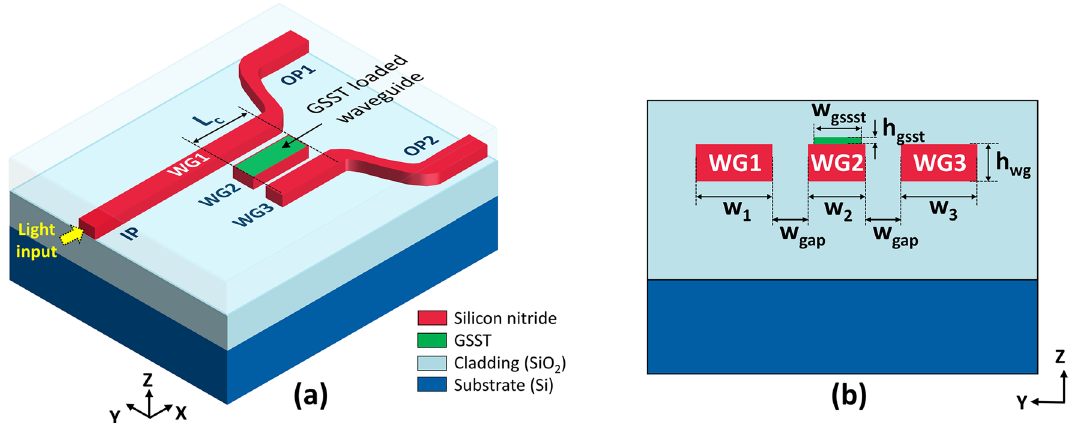
Figure 2. ( a ) Proposed SDC incorporating two identical waveguides WG1 and WG3, which are mediated by a GSST loaded waveguide WG2 in the coupling region of a length L c . ( b ) Cross-sectional view of the SDC with the structural parameters